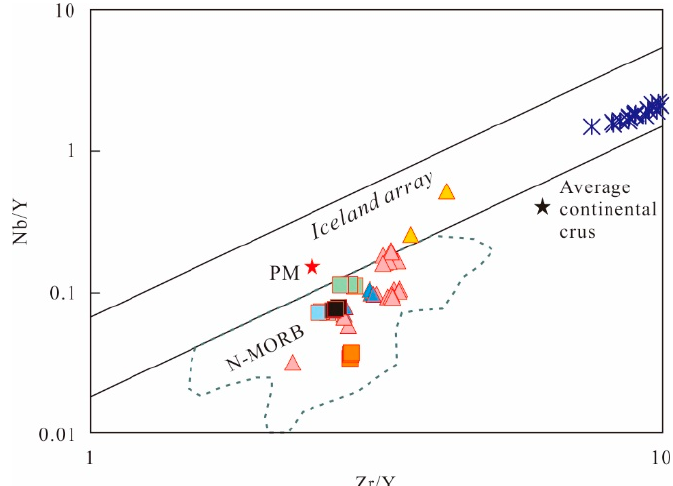
Figure 7. Nb/Y versus Zr/Y diagram (after [74] and references therein) of the basalts from the SMAR at 18–21°S. The data are from [9,28,30]. The parallel lines indicate the lower and upper limits of the Iceland data array. The lower line with Δ Nb = 0 ( Δ Nb = 1.74 + log(Nb/Y) –1.92 log(Zr/Y), representing deficiency or excess in Nb relative to the lower line) separates the parallel Icelandic ( Δ Nb > 0) and N-type mid-ocean ridge basalts (N-MORB; Δ Nb < 0). Symbols are the same as in Figure 2.